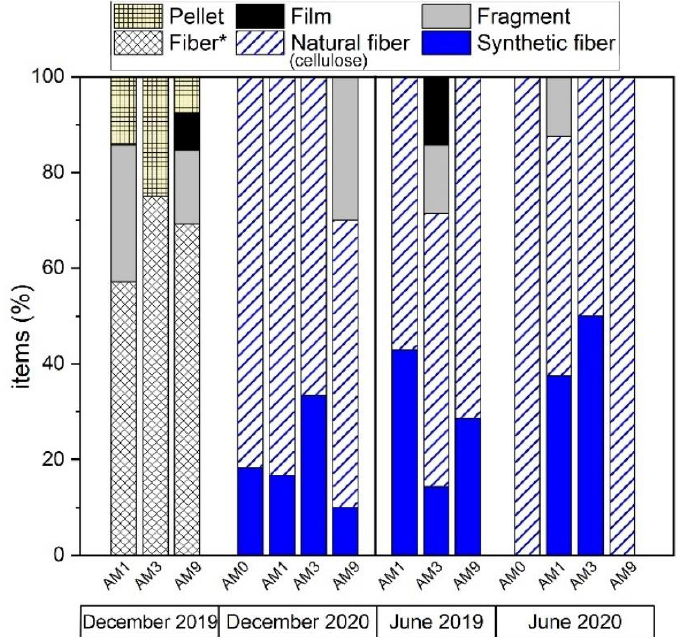
Figure 8. Particle classification (%) in water samples based on the shape. Fibers were distinguished as synthetic or natural or indicated with * when this distinction was not made.